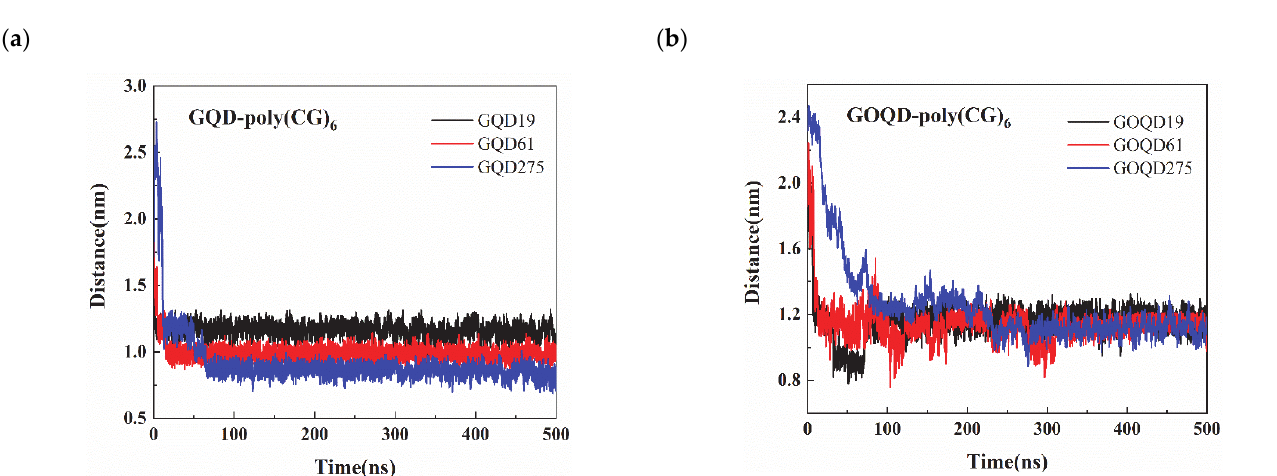
Figure 5. The COM distance between dsDNA and GQD /GOQD in z ‐ direction during the simulation time: ( a ) GQD ‐ poly(CG) 6 and ( b ) GOQD ‐ poly(CG) 6 . time: ( a ) GQD-poly(CG) 6 and ( b ) GOQD-poly(CG) 6